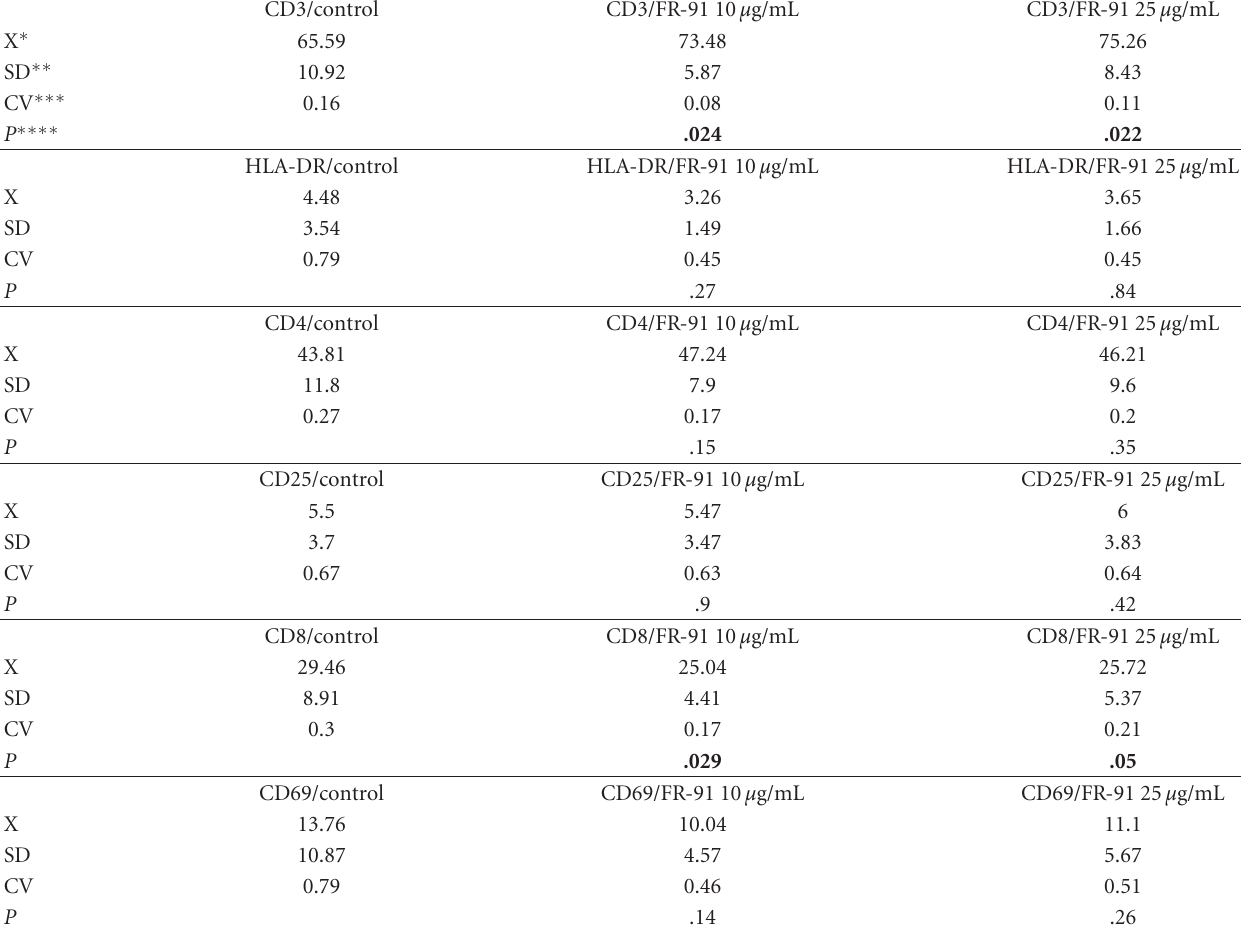
Table 1: E ff ect of FR-91 on peripheral blood mononuclear cell (PBMC) subsets from healthy